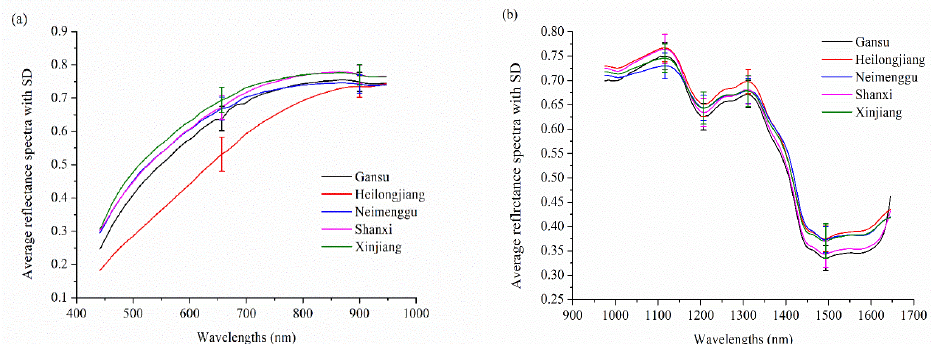
Figure 3. The average spectra with standard deviation (SD) of Radix Astragali from five origins in the range of ( a ) 441–947 nm (the standard deviation at 657 and 900 nm are shown); ( b ) 975–1646 nm (the standard deviation at 1116, 1207, 1311 and 1494 nm are shown).